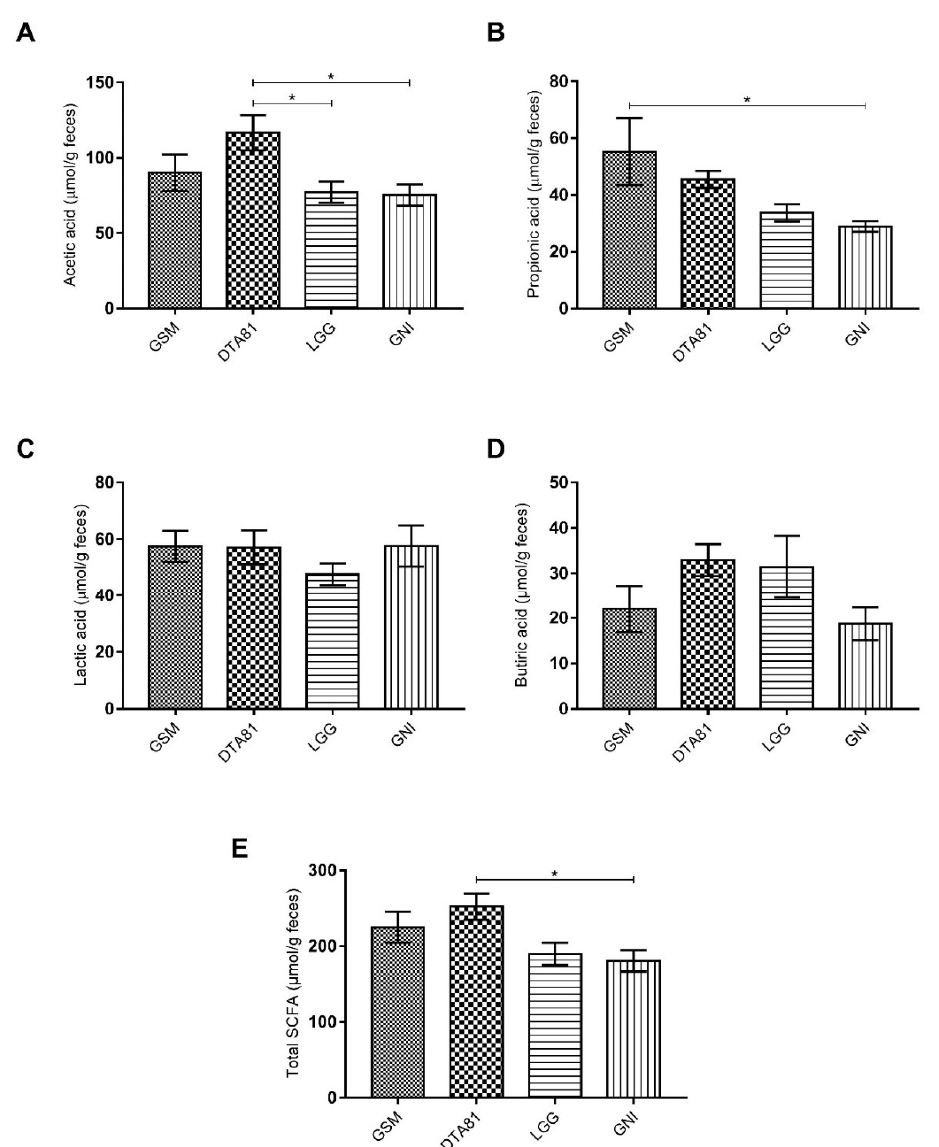
Figure 4. Caecal concentration of short-chain fatty acids (SCFAs). ( A ) Acetic acid; ( B ) propionic acid; ( C ) lactic acid; ( D ) butyric acid; ( E ) total SCFA. Values are means ± SEM ( n = 6). *, p ≤ 0.05.